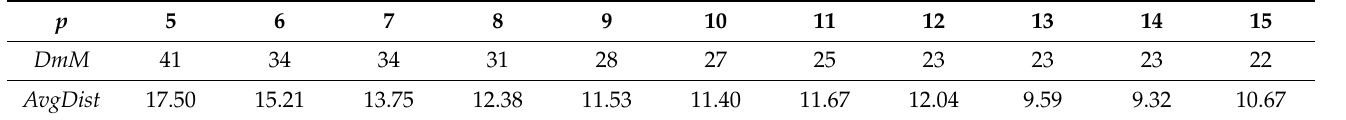
Table 2. Results of numerical experiments with minMax model (19)–(26) using the dataset for the self-governing region of